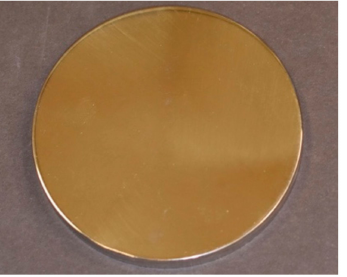
Figure 1. Stainless-steel plate (110 × 10 mm 2 ).